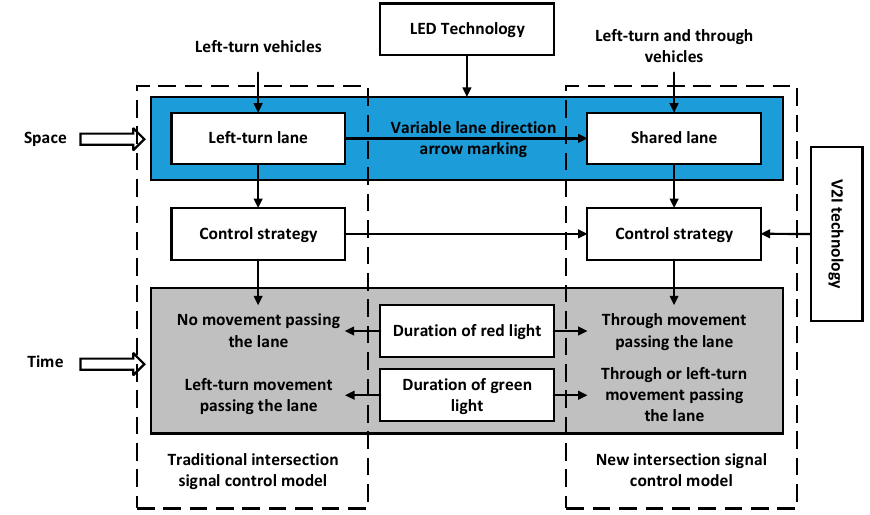
Figure 3. The control principle diagram. LED: light-emitting diode; V2I: vehicle-to-infrastructure.